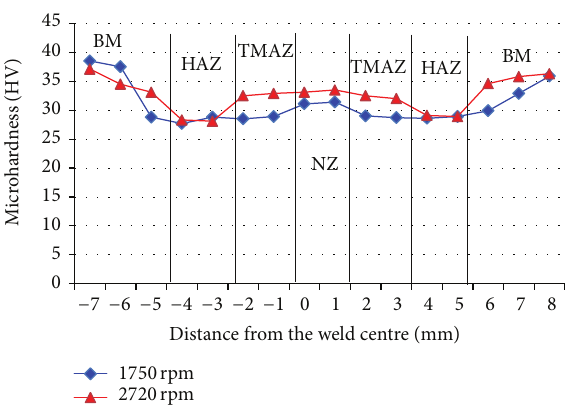
Figure 13: X-ray superimposed diffraction patterns of the Al-Al FSW joint. (a) BM and (b) NZ at rotating speed of 1750 rpm and (c) NZ at rotating speed of 2720 rpm.